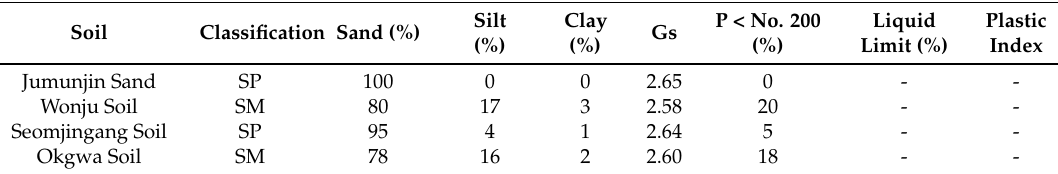
Figure 15. Soil particle size distribution curves. Table 3. Physical properties of soils used.